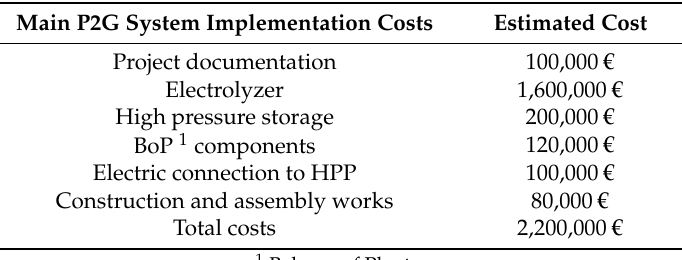
Table 2. The cost of the components of P2G